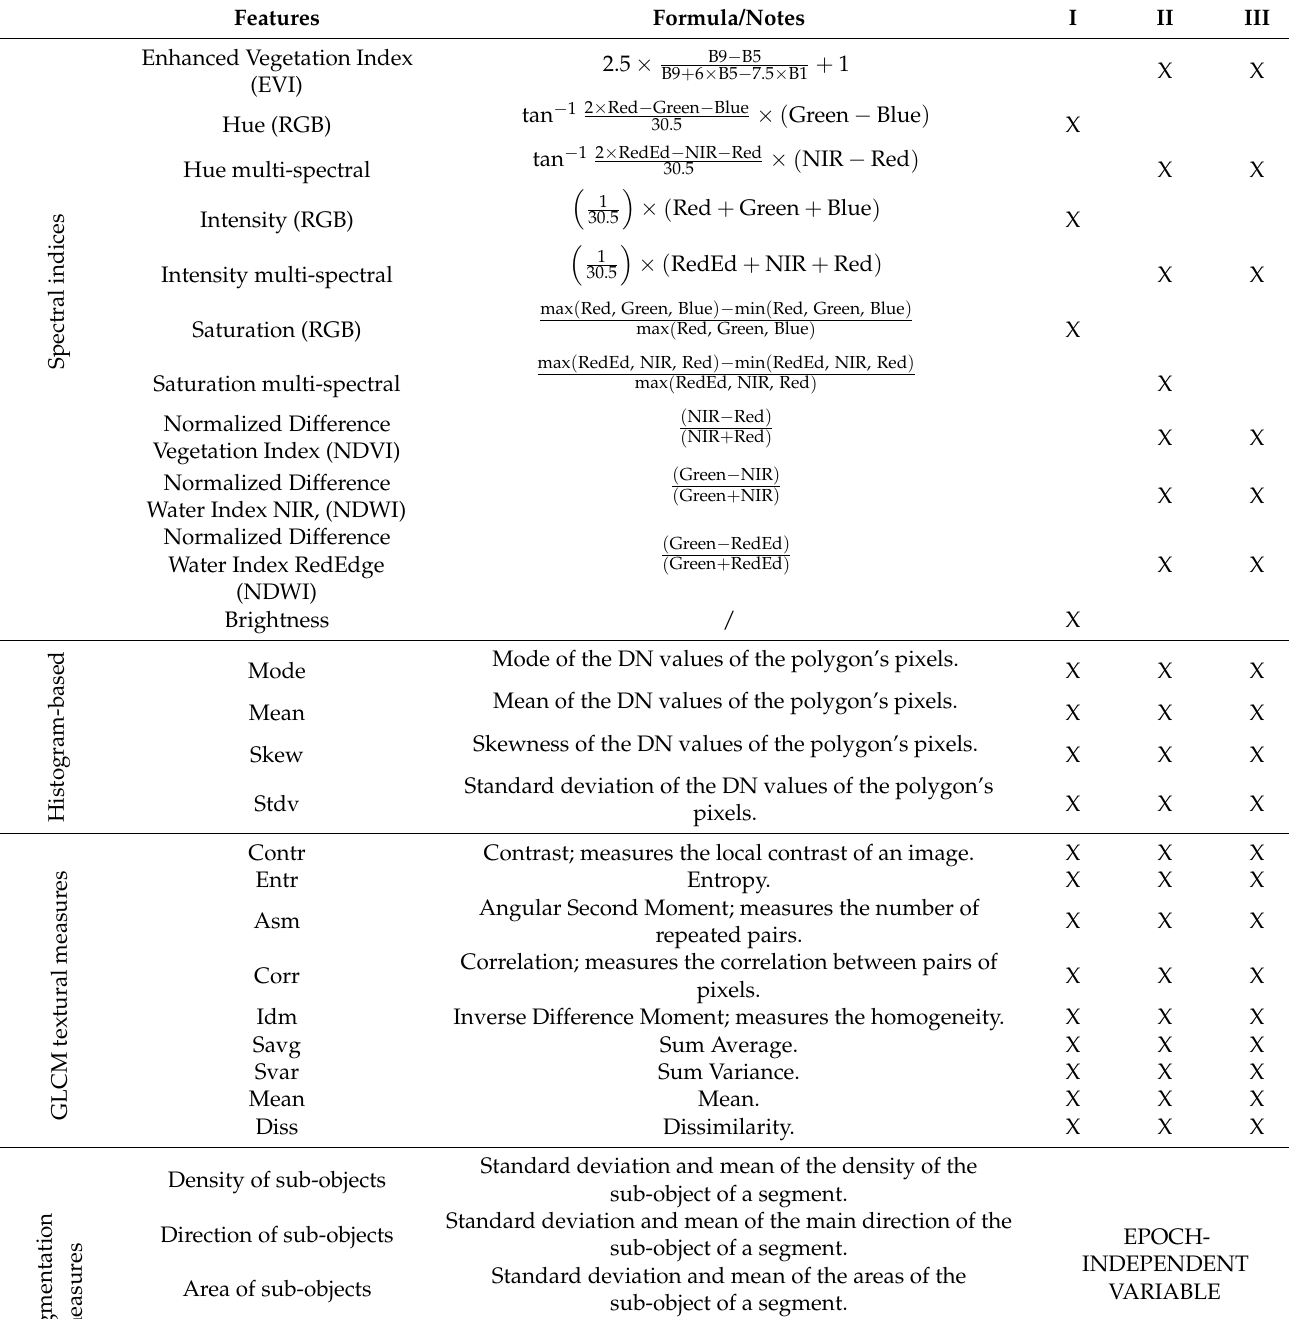
Table 5. Features of the classification. X indicates if the feature was calculated for I (epoch I), II (epoch II), and III (epoch III).